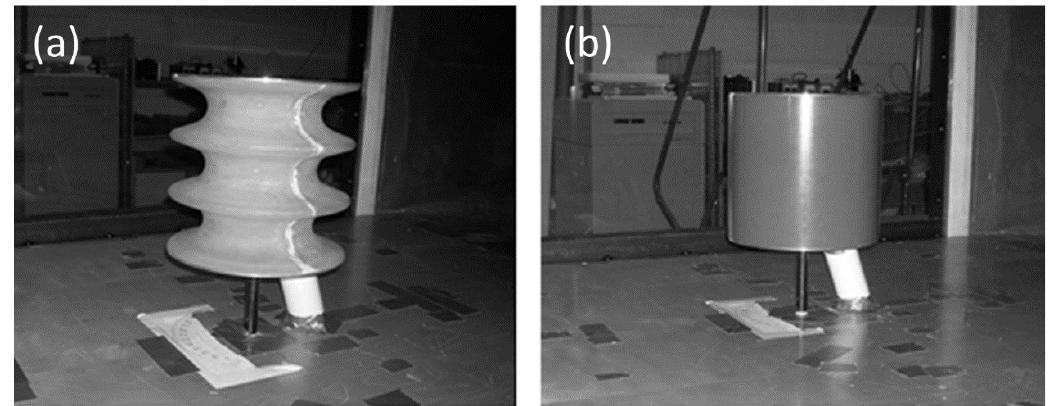
Figure 4. Experimental set-up for the ( a ) corrugated and ( b ) smooth models.